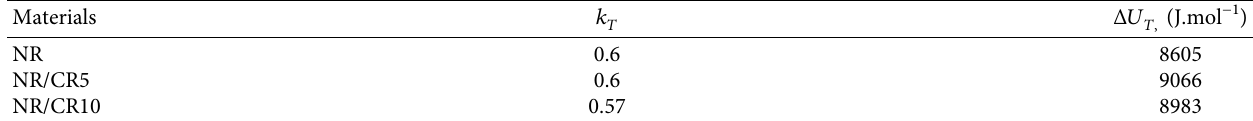
Table 5: Δ U T of NR and NR/CR blends after the heat aging.